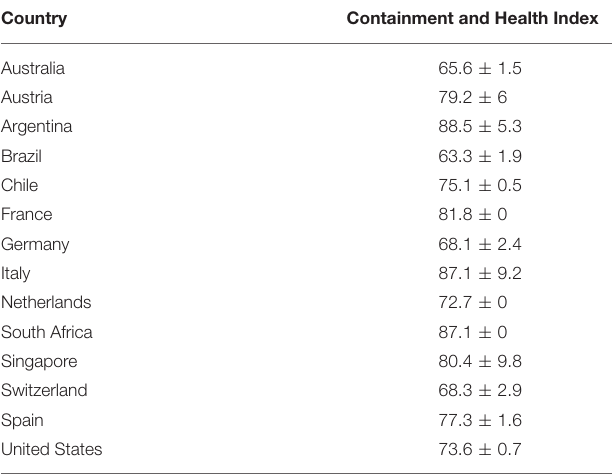
The table lists mean percentage values and standard deviation of changes during the study period. Higher values represent more restrictive